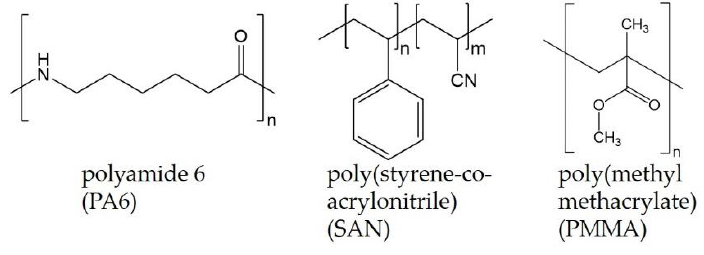
Figure 1. Chemical structure of the polymers PA6, SAN, and